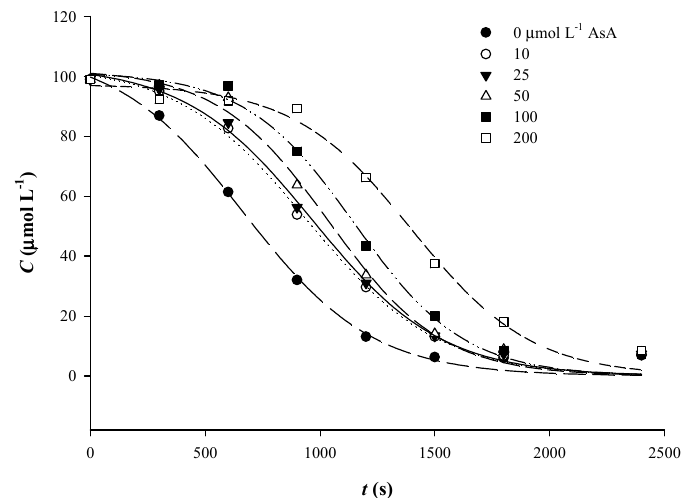
Figure 5. Implementation of the sigmoidal kinetic model to trace Qt thermal degradation in the presence of various concentrations of AsA. Table 3. The effect of antioxidants on Qt degradation kinetics using the sigmoidal